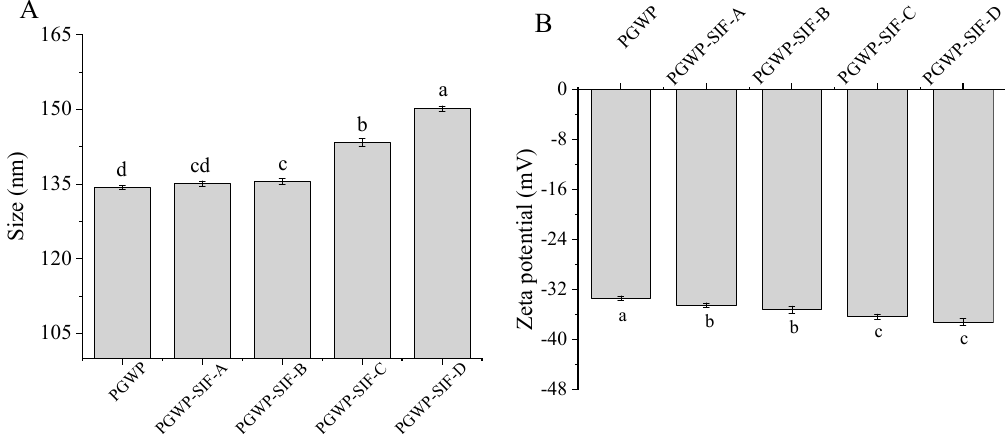
Figure 2. Effects of the SIF contents on particle size ( A ) and zeta potential ( B ) of PGWP-SIF. Different subscript letters indicate a significant difference ( P < 0.05). Error bars represent standard deviation of the means.